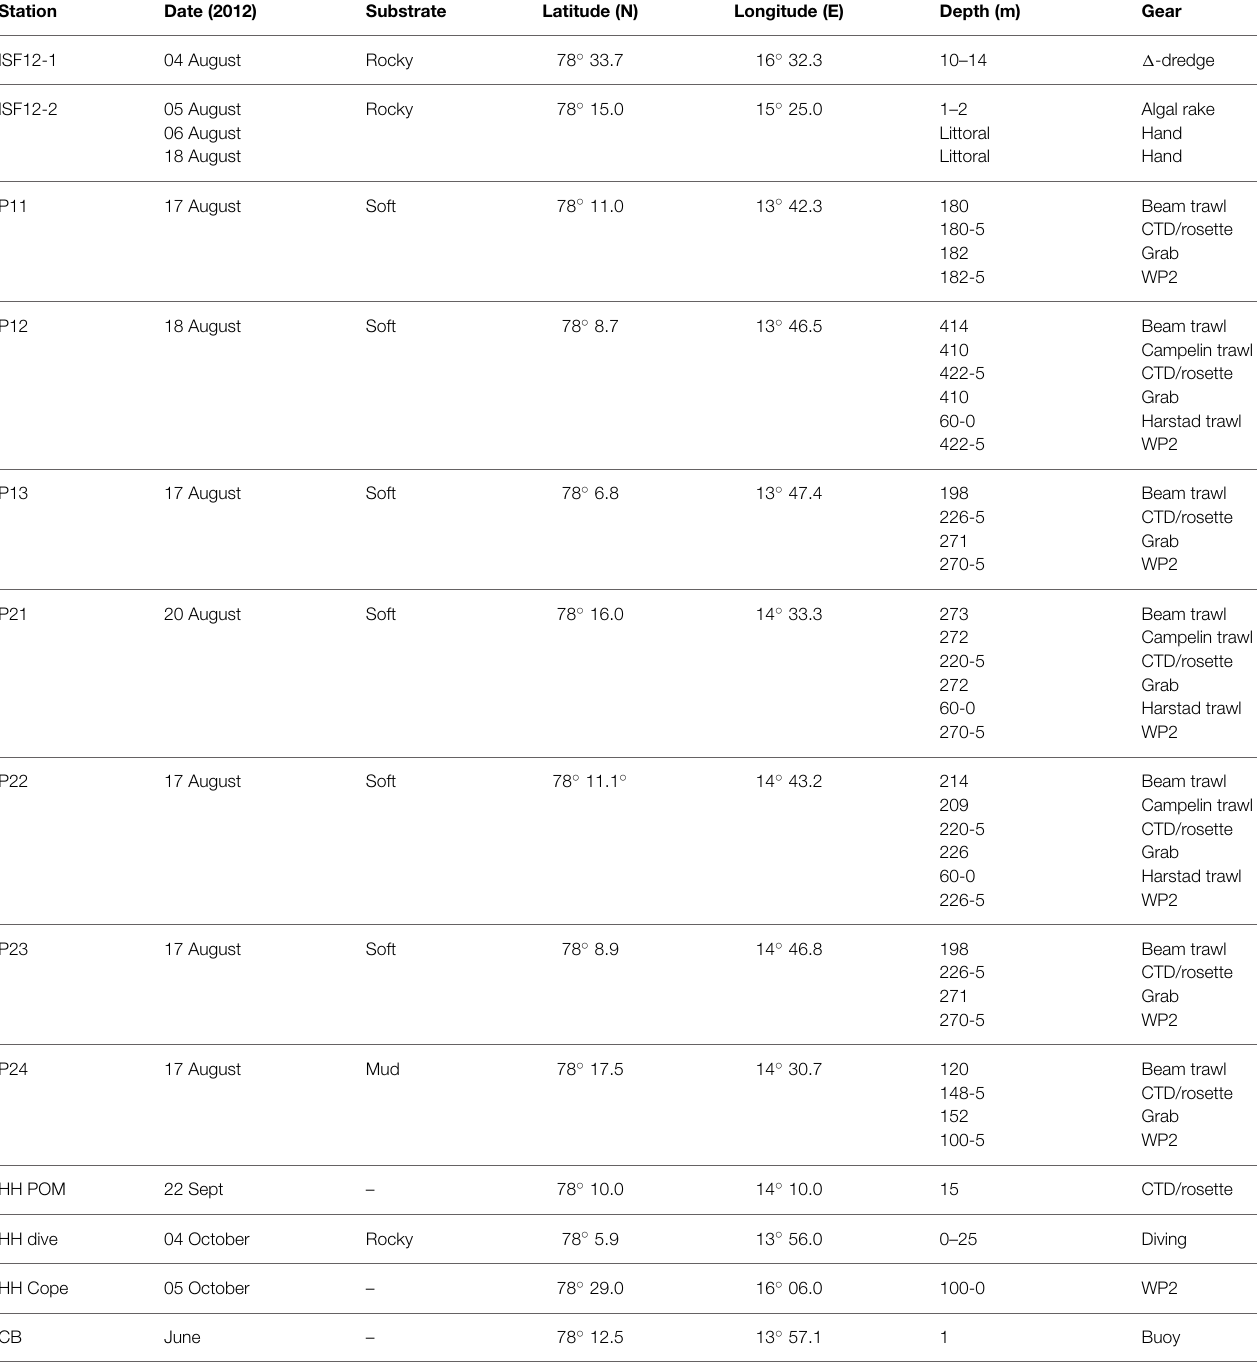
TABLE 1 | Sampling sites and collection